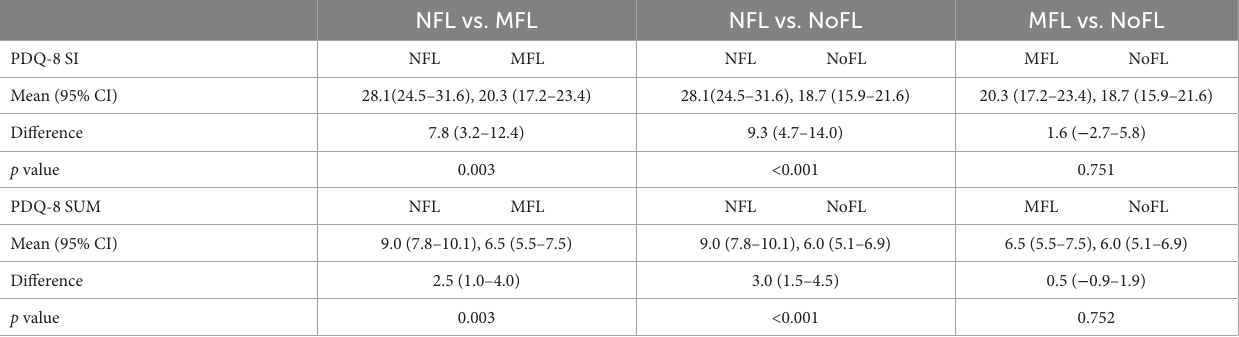
TABLE 2 Multivariable analysis of the association between PDQ-8 SUM/PDQ-8 SI and the three groups according to the results of